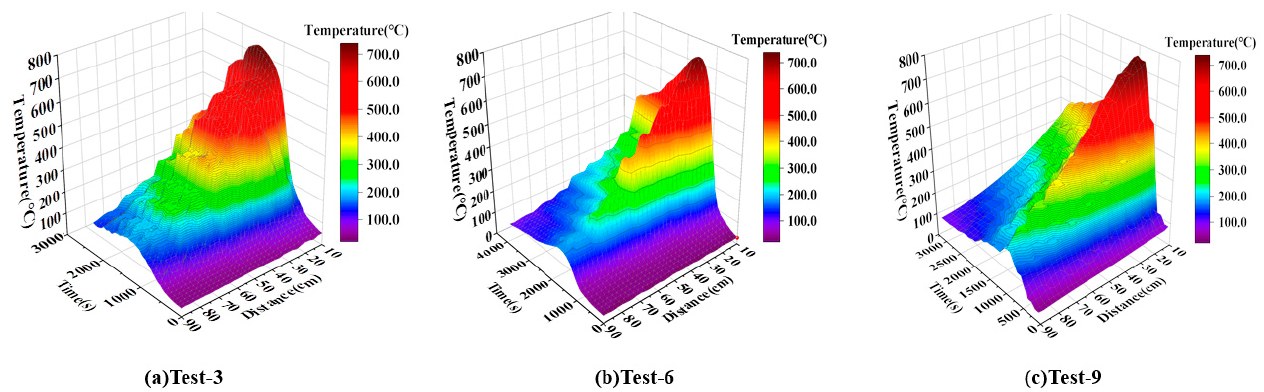
Figure 9. The flame temperature changes of Test-3, Test-6, and Test-9 (where ( a ) is a coal pile of 40 cm diameter and 6 cm thickness, ( b ) is a coal pile of 60 cm diameter and 6 cm thickness, ( c ) is a coal pile of 80 cm diameter and 6 cm thickness).